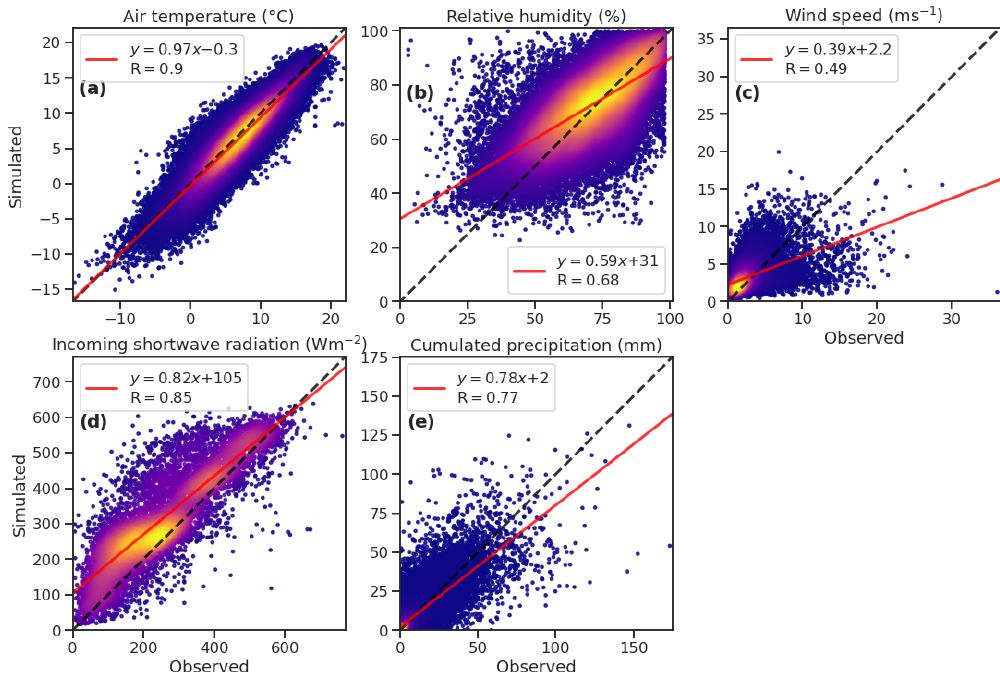
Figure 3. Comparison of in situ observed data and WRF simulations of daily air temperature (a) , relative humidity (b) , wind speed (c) , incoming shortwave radiation (d) and precipitation (e) for the three snow seasons. The density of observations for each pixel of the plot is represented with a color; the brighter the color, the higher the density of observations for that pixel. Table 3. WRF mean bias error (MBE), mean absolute error (MAE) and correlation coefficient ( R ) of air temperature, relative humidity, wind speed, incoming shortwave radiation and daily precipitation, for low elevation ( < 800m), mid-elevation (800–1600m) and high elevation ( ≥ 1600m) bands for the three snow